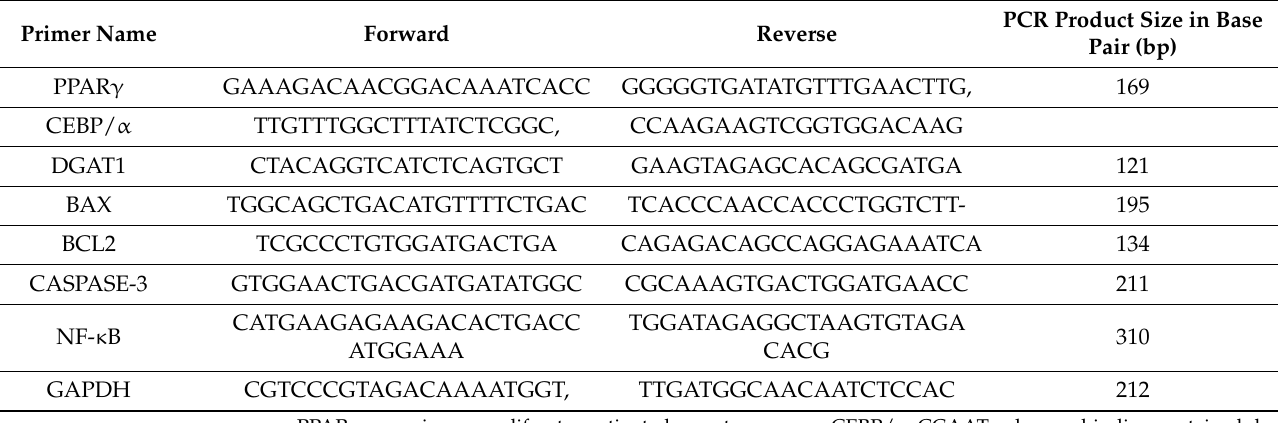
Table 2. Real-time PCR primer